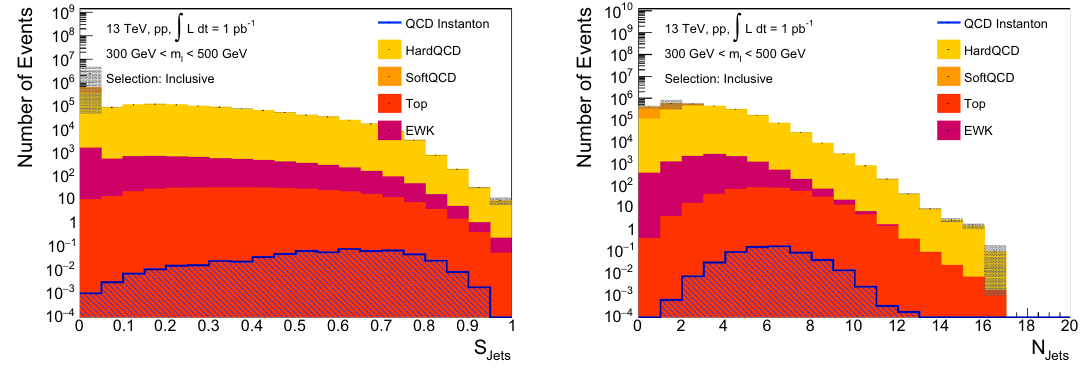
Fig. 17 Predicted distributions of the event sphericity (left) and num- ber of reconstructed jets (right) for various processes, weighted by their predicted cross sections for an integrated luminosity of L = The invariant mass of all reconstructed tracks is required to be between